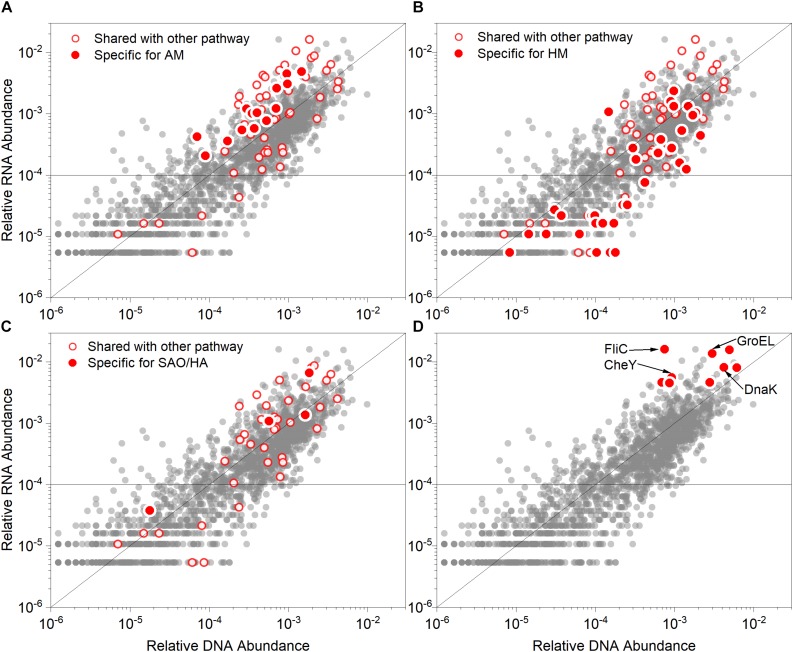
Relative abundance values of genes (DNA) and corresponding transcripts (RNA) associated with the metabolisms of (A) acetoclastic methanogenesis (AM), (B) hydrogenotrophic methanogenesis (HM), (C) Syntrophic acetate oxidation/Homoacetogenesis (SAO/HA) and (D) prominent overexpressed genes. The red points in (A–C) indicate genes specific for the described pathways, while the red circles represent genes shared with other methanogenic pathways. The red points in (D) highlight the prominent genes (both highly overexpressed and abundant). Each scatterplot illustrates the gene and transcript relative abundance based on KO databases (gray points). The function line of y = x was graphed to distinguish between overexpressed (points above the line, indicating RNA > DNA) and under-expressed genes (points below the line, indicating RNA < DNA). The horizontal line indicates that the relative RNA abundance was 0.01%. GroEL, chaperonin GroEL; DnaK, molecular chaperone; CheY, chemotaxis family, response regulator; FliC, flagellin.